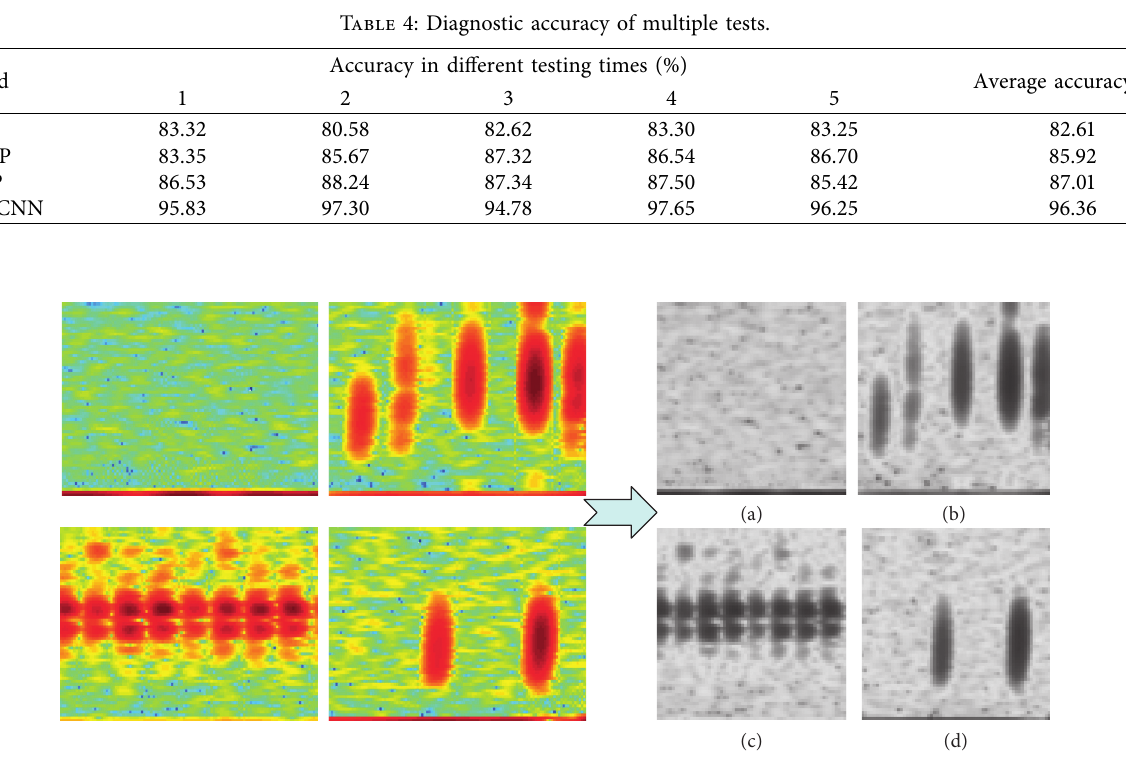
Figure 13: Time-frequency maps at different states: (a) normal signal, (b) inner ring failure, (c) outer ring failure, and (d) rolling element